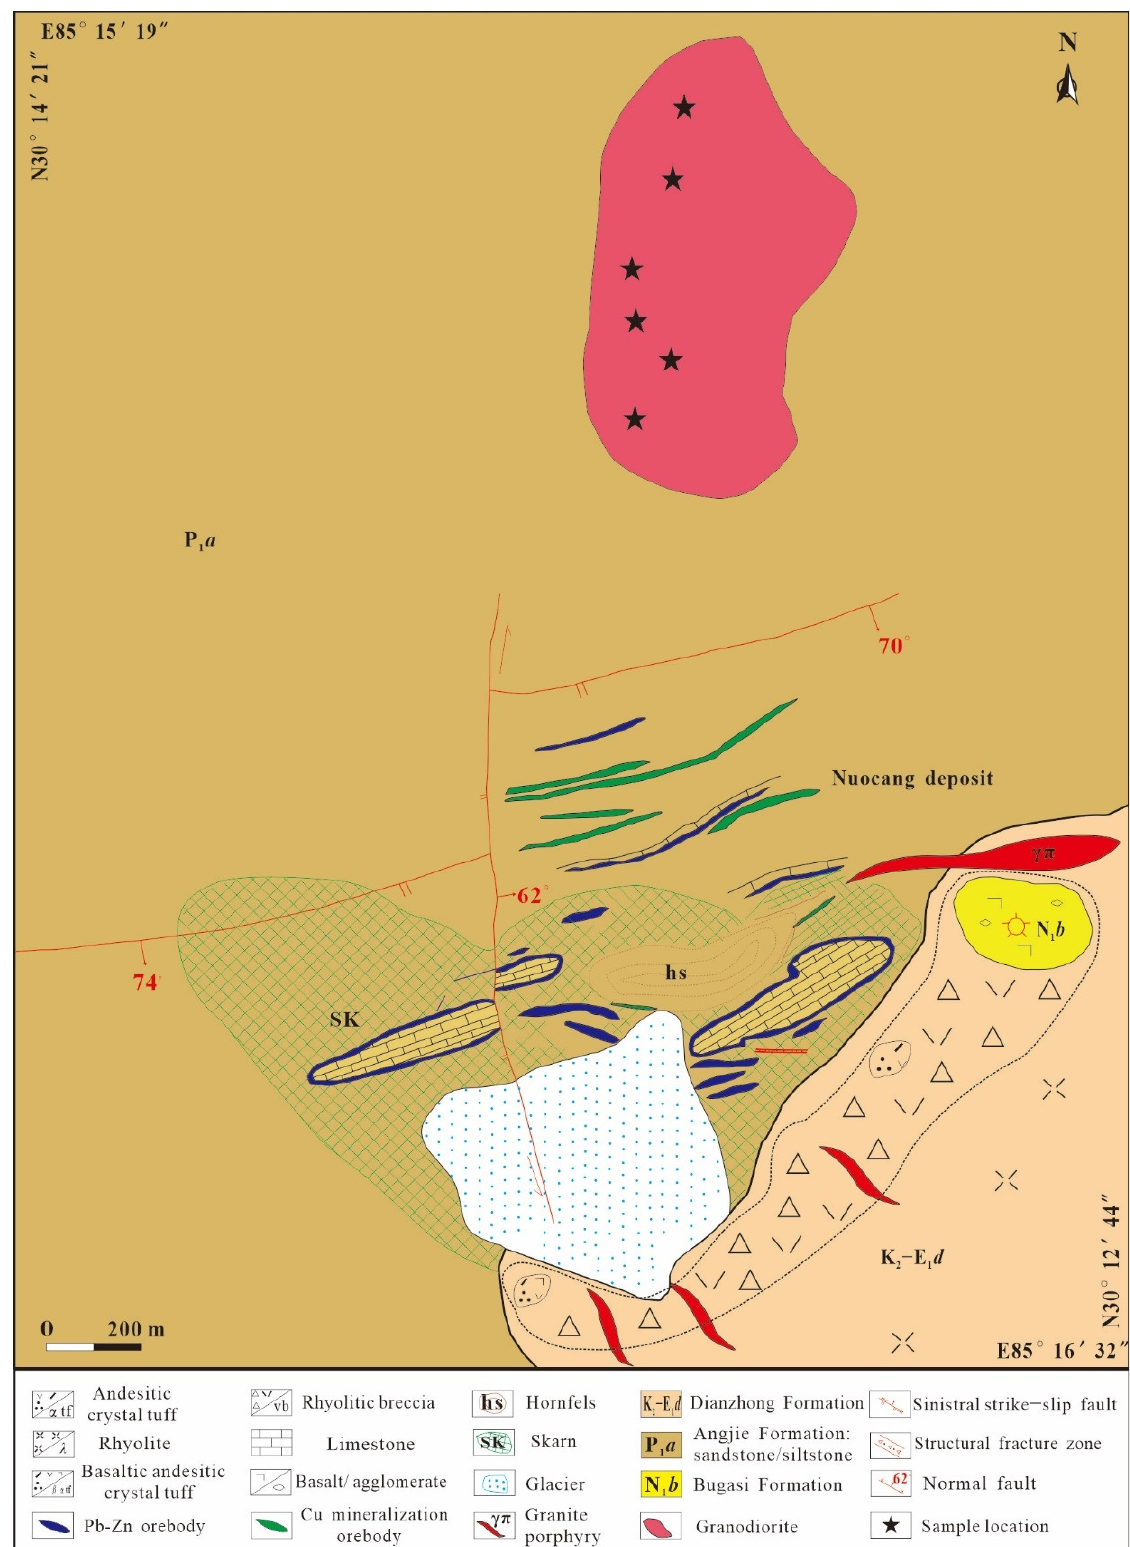
Figure 2. Simplified geological map of the Nuocang district, southern Lhasa terrane (modified after [36]).